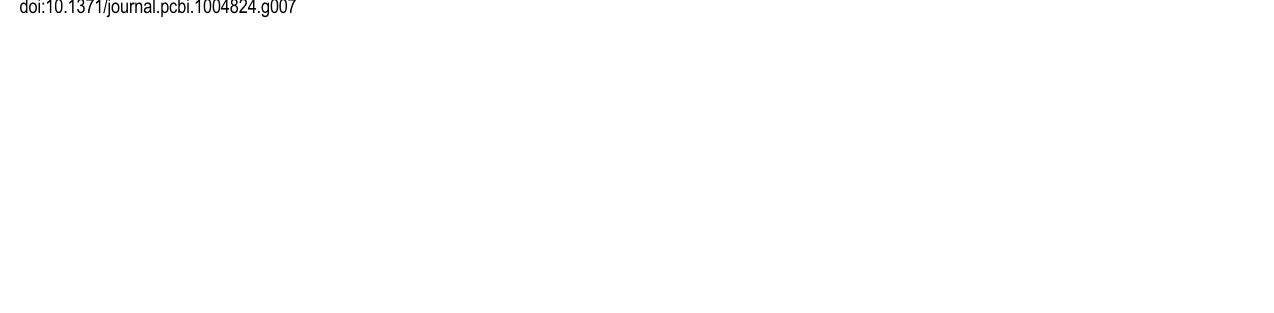
PLOS Computational Biology | DOI:10.1371/journal.pcbi.1004824 June 30,